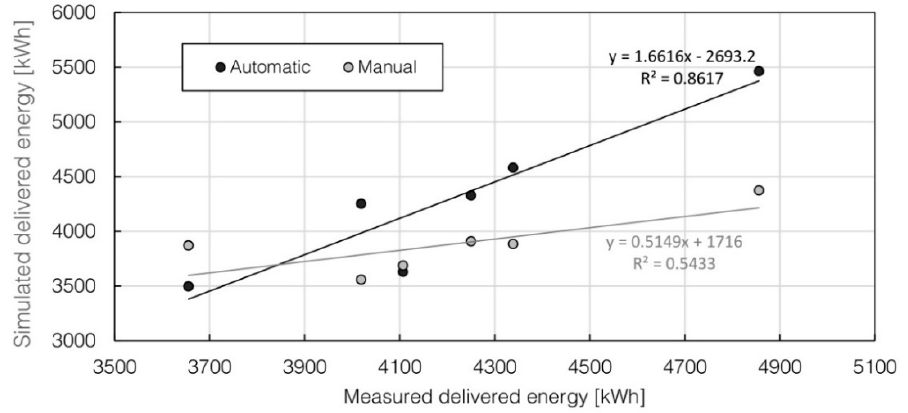
Figure 18. Scatter plot of delivered energy from manual and automatic calibrated models compared with real consumption from bills.